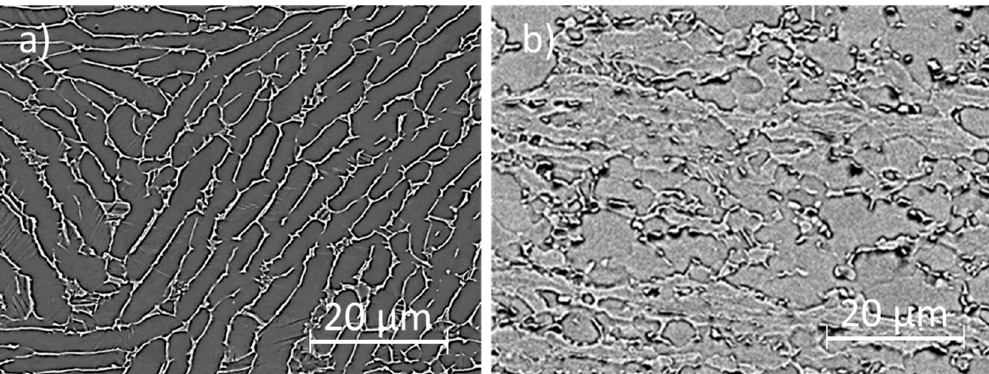
Figure 1. ( a ) Lamellar and ( b ) equiaxed microstructures of the Ti-6Al-4V plates. Table 1. Chemical compositions of the 2.0 and 5.8 mm equiaxed plates and the 3.0 and 3.8 mm lamellar plates. Plate Thickness